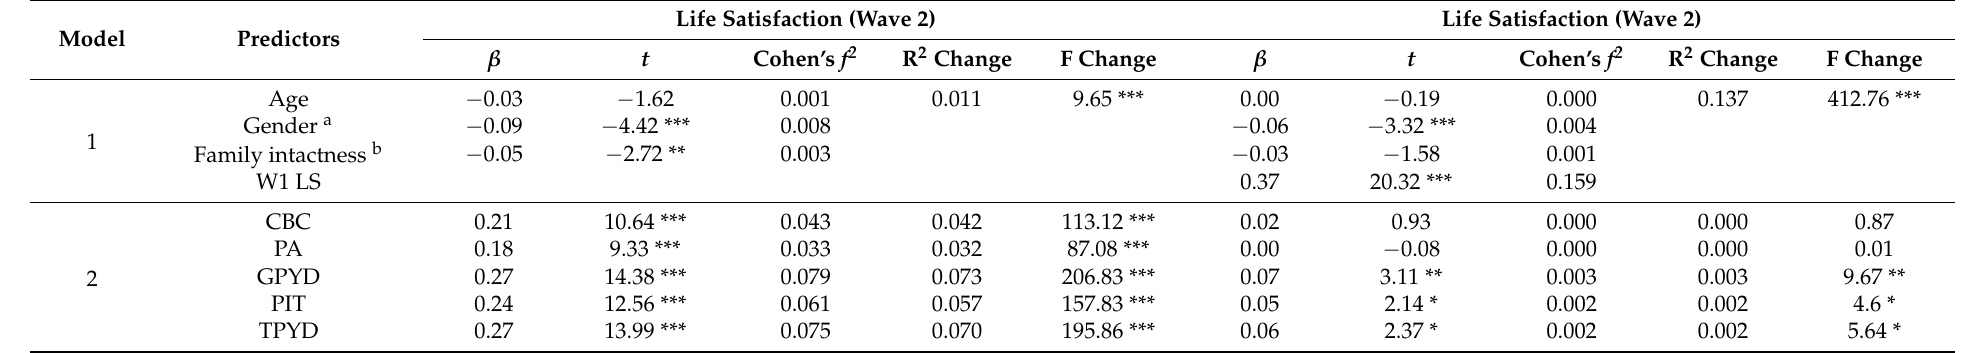
Table 6. Longitudinal regression analyses for life satisfaction.